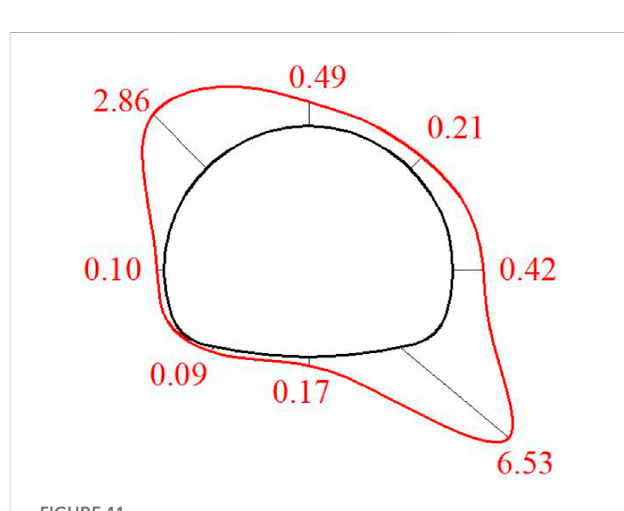
FIGURE 11 Pressure of surrounding rock (unit: